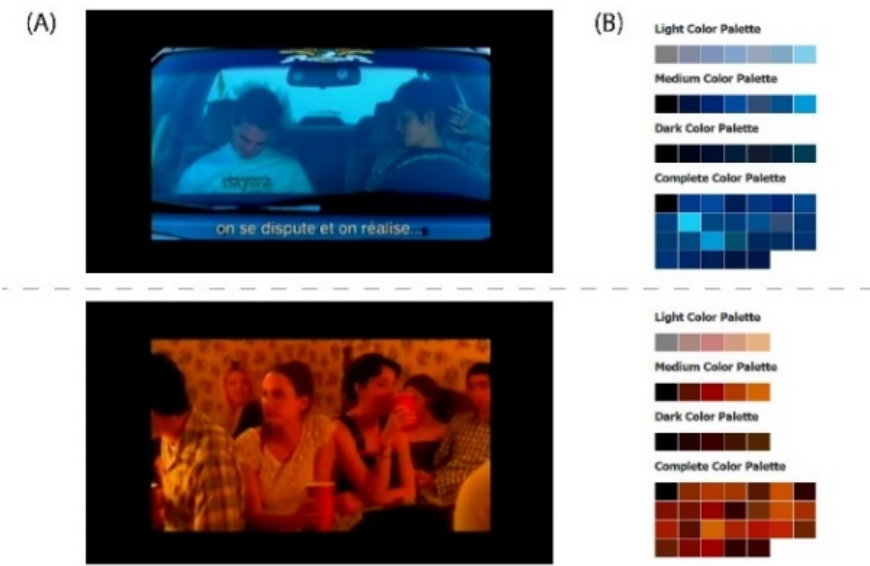
Figure A2. ( A ) DEAP Dataset Experiment_id (17) ‘All I Need’ Music Video from AIR’s album ‘Moon